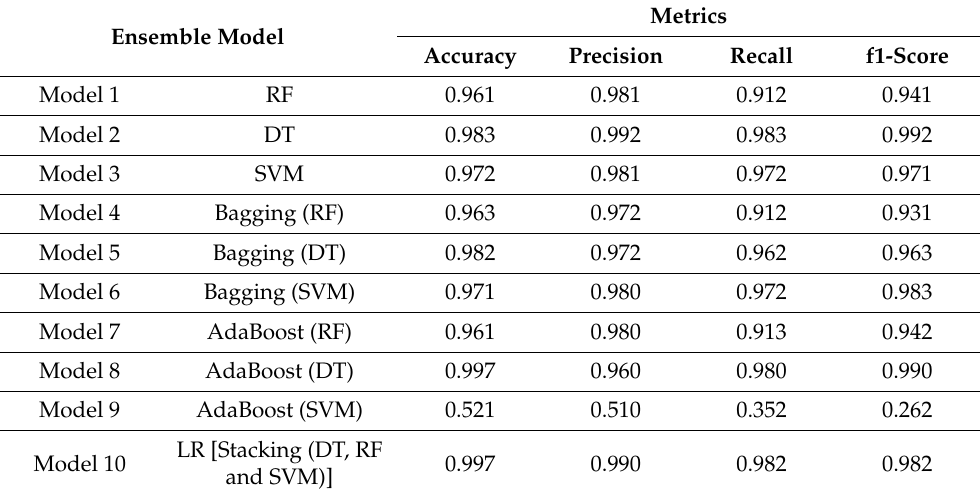
Table 5. Summary of overall